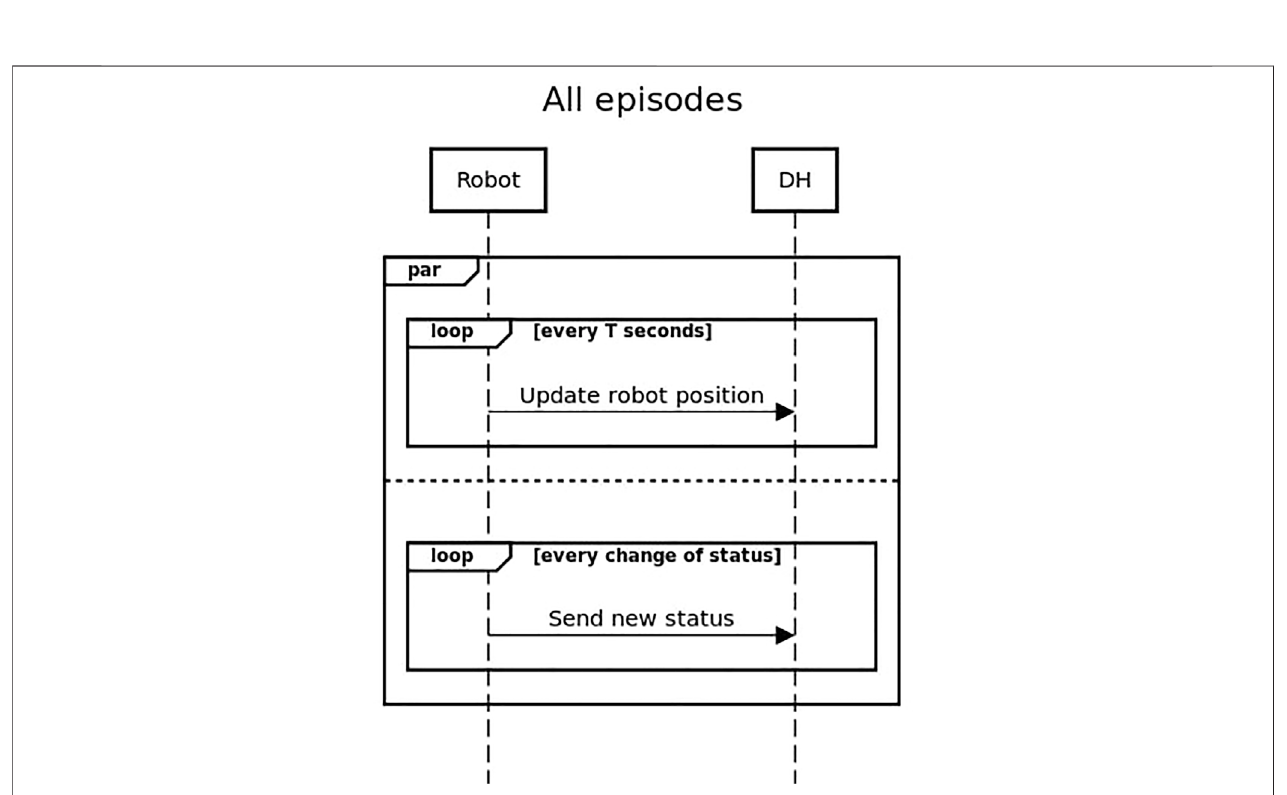
FIGURE 6 | Sequence diagram showing the general interaction between the robot and the Data Hub. This is valid for all episodes.